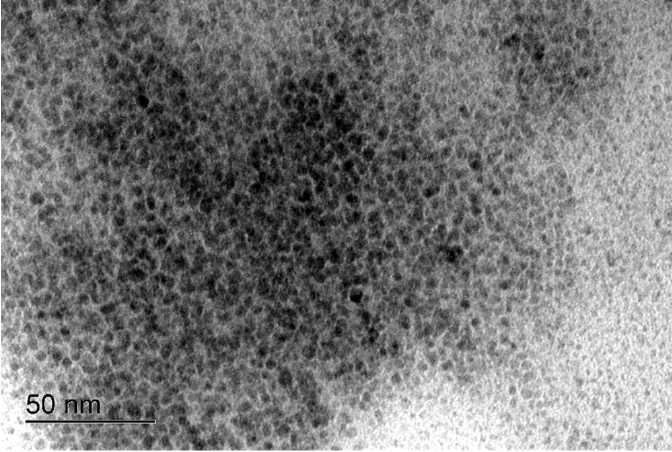
Figure 2. Representative bright-field TEM image of PPy/AuNPs 15 s. The PPy and PPy/AuNP materials were characterized by FTIR spectra, as shown in Figure 3a.